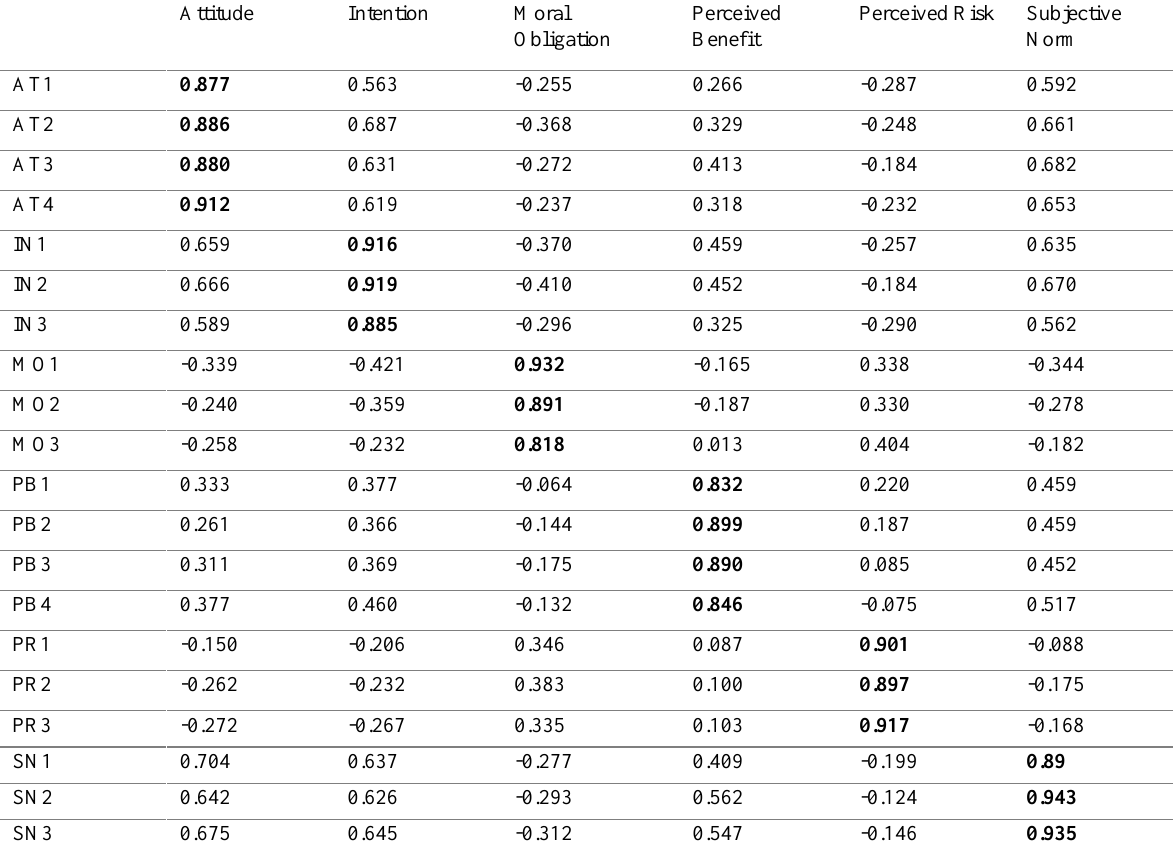
Table 2: Result of measurement model - discriminant